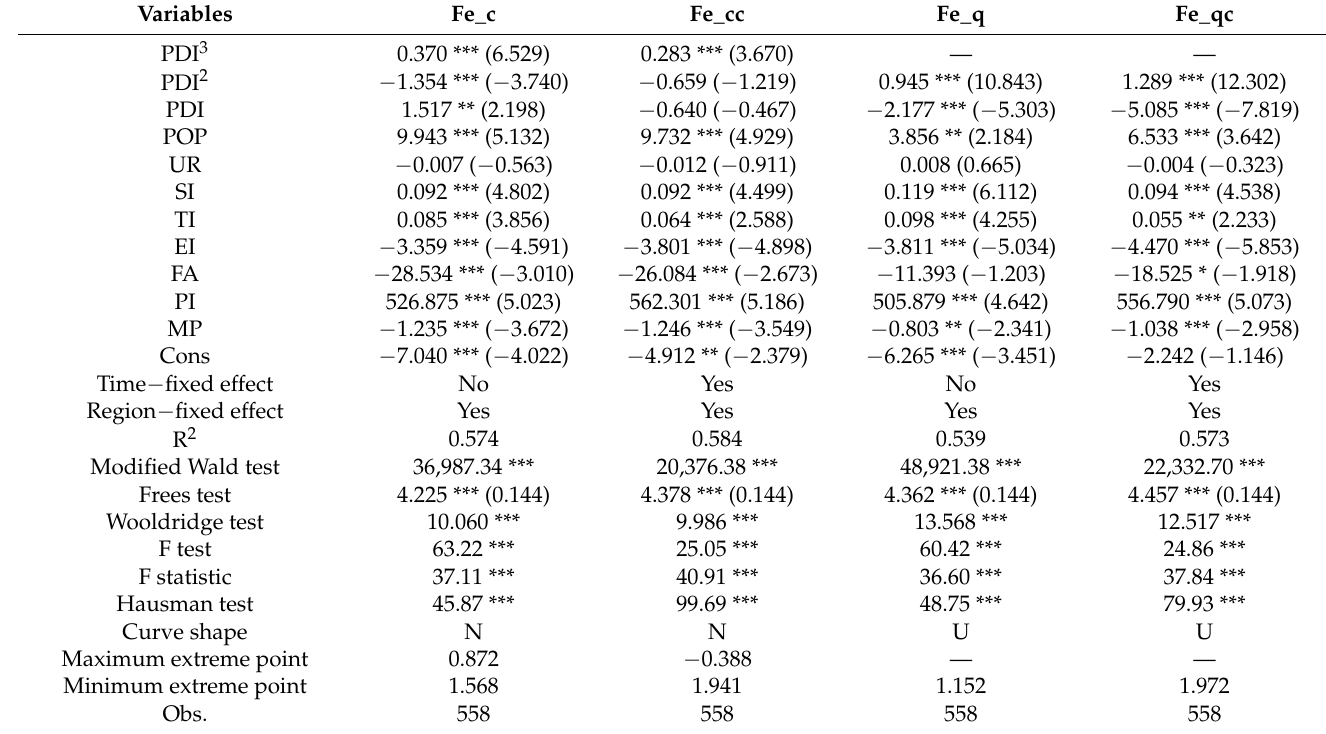
Table 7. Estimation results of the replacement explanatory